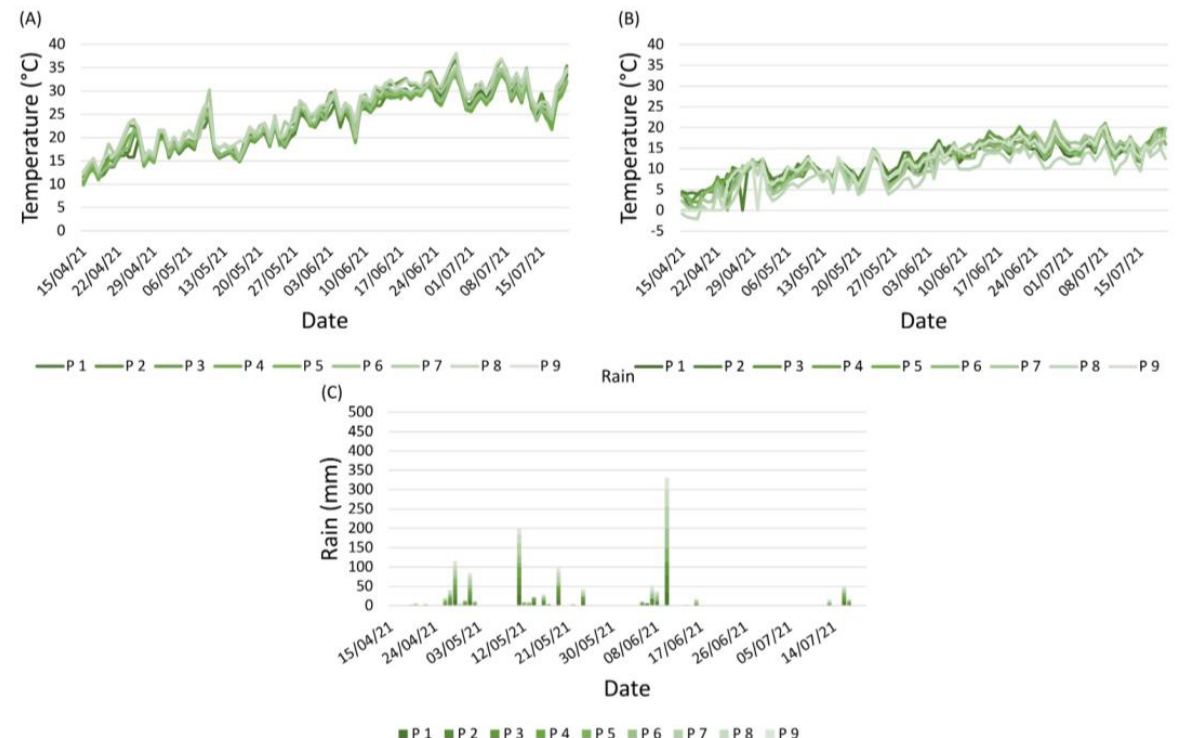
Figure 6. Weather conditions occurring from April to July 2021: daily maximum temperature ( A ), minimum temperature ( B ), and rainfall ( C ) in the nine vineyards (P1–P9). Different shades/colours represent different vineyards.